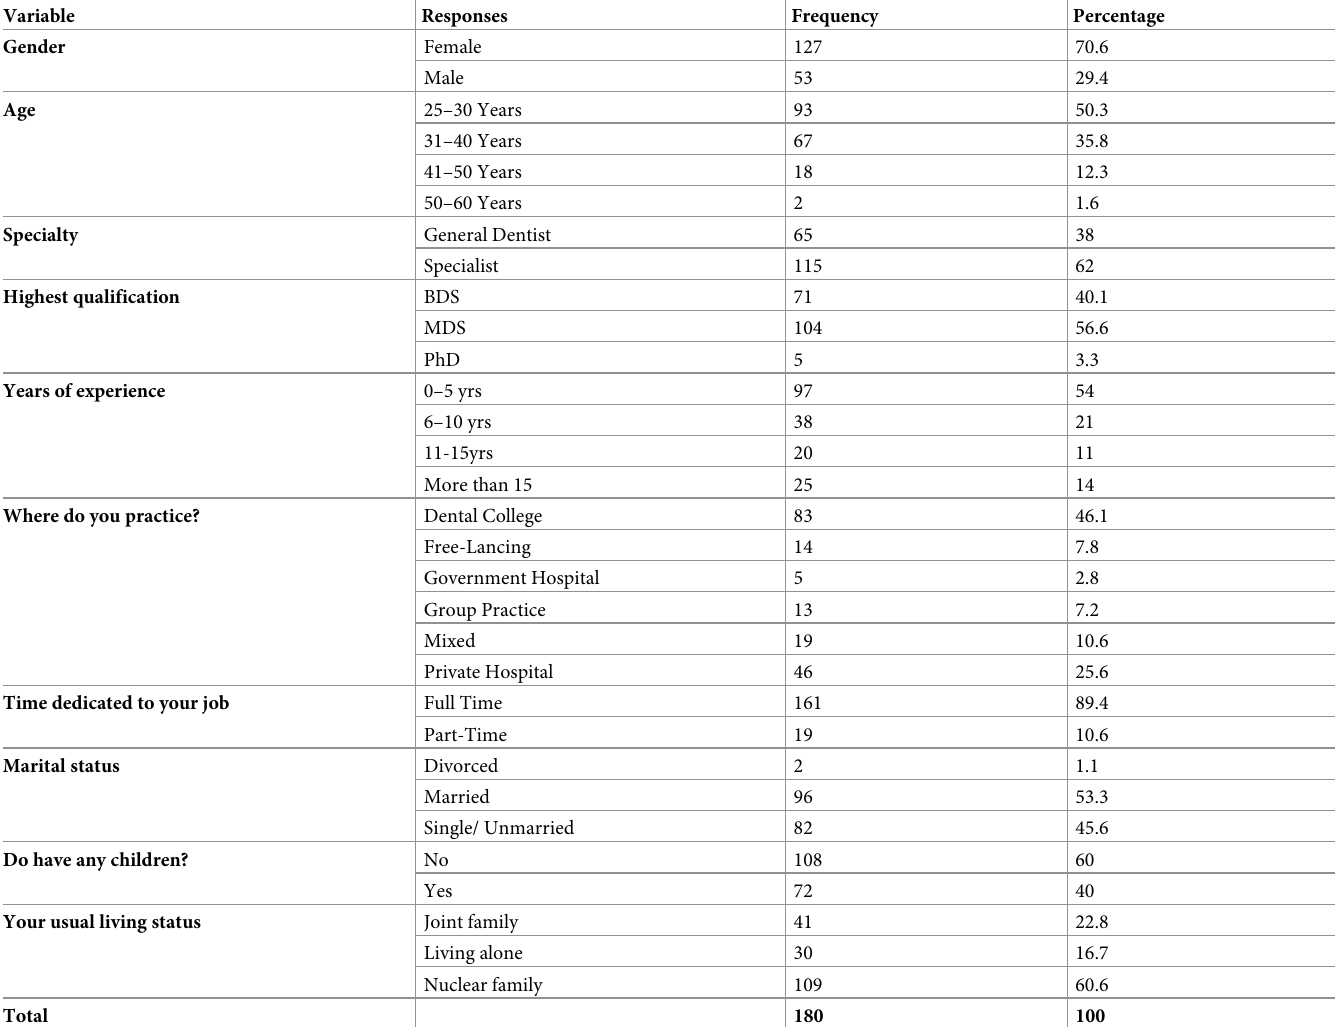
Table 1. Demographic and workplace